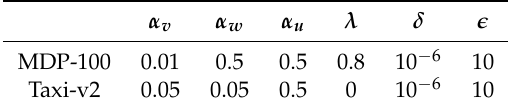
Table 2. Optimal Parameters for DP-Actor.